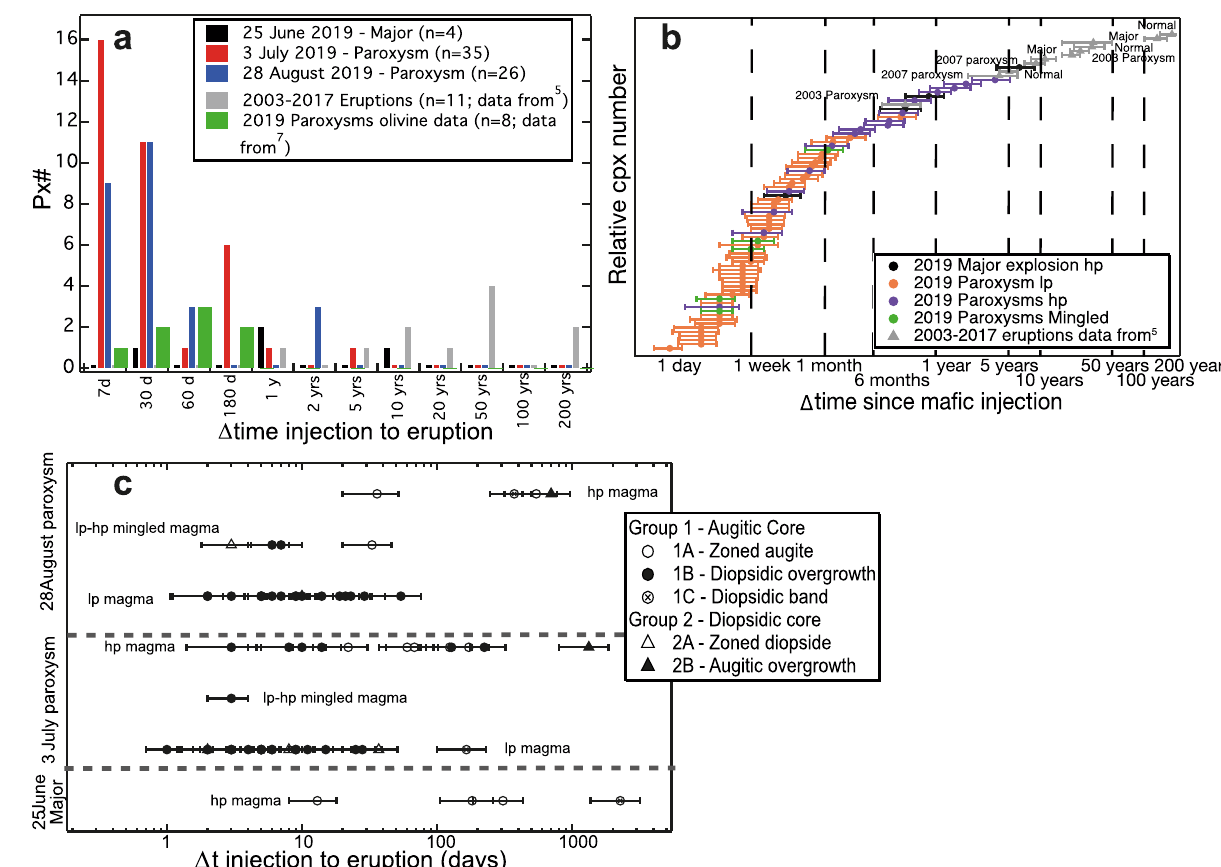
Fig.5|Fe-Mgtimescalesforthe2019clinopyroxenes.a Histogramshowingthe numberofclinopyroxene vs timescales( 4 timeinjection – eruption,indaysand years) from ma fi c injection to eruption for 25 June (black) major explosion, 3 July (red) and 28 August (blue) paroxysms. Timescales for the 2003 – 2017 eruptive period from Di Stefano et al. 3 are also shown (grey), alongside the timescales calculated from olivine crystals by Métrich et al. 5 for the two 2019 paroxysms (green). n = number of timescales estimate. b Timescales are pre- sented in order of increasing 4 time and are plotted according to the different type of erupted magmas ( fi lled circle) – black: 25 June major explosion hp - magma; orange: 3 July and 28 August paroxysms lp -magma; purple: 3 July and